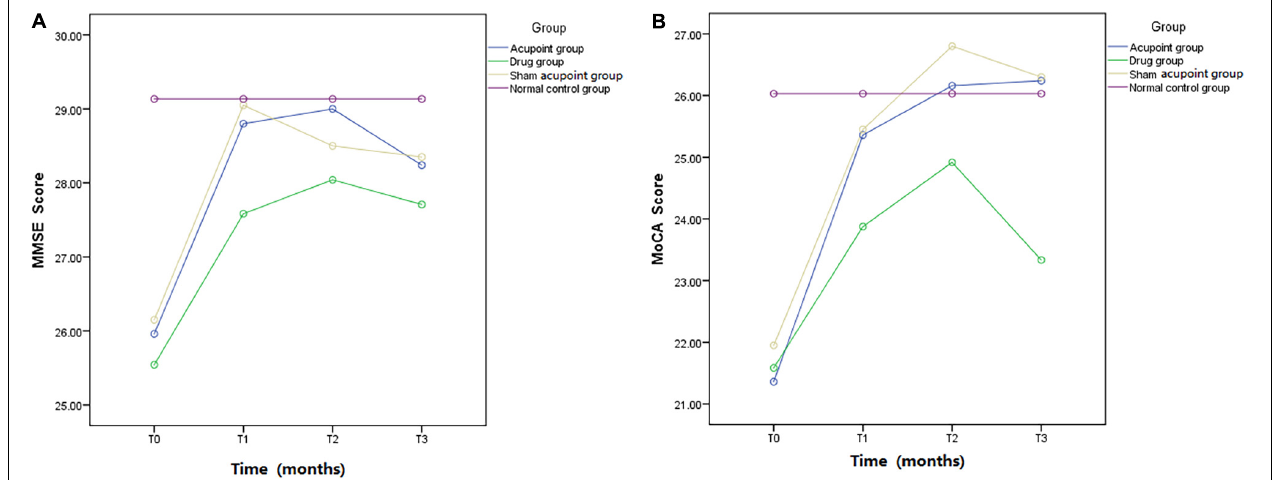
FIGURE 3 | Mini-mental state examination and Montreal Cognitive Assessment. MMSE and MoCA scores in the acupoint group, drug group, sham acupoint group, and the normal control group.